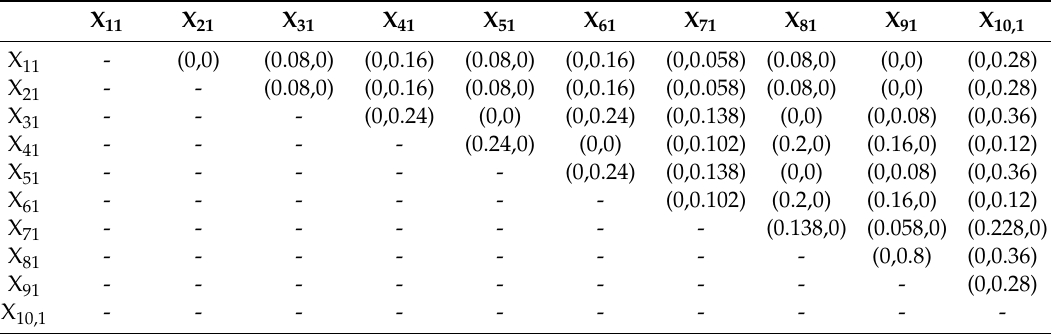
Table 21. The distance between two alternatives g and f with respect to each